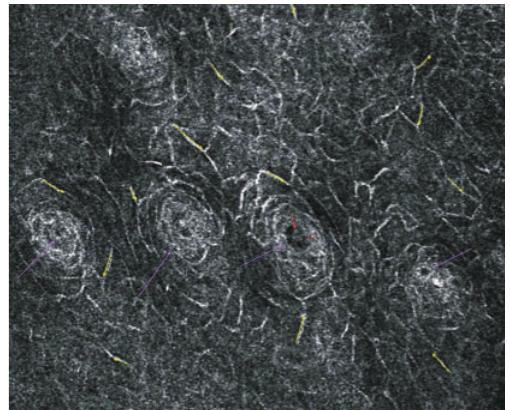
Figure 8: Reflectance confocal microscopy image at prickle cell lay- er (Z3). Yellow lines: reticular or wider honeycomb pattern, Purple arrows: dermal papillae, Red arrows: blood vessels.